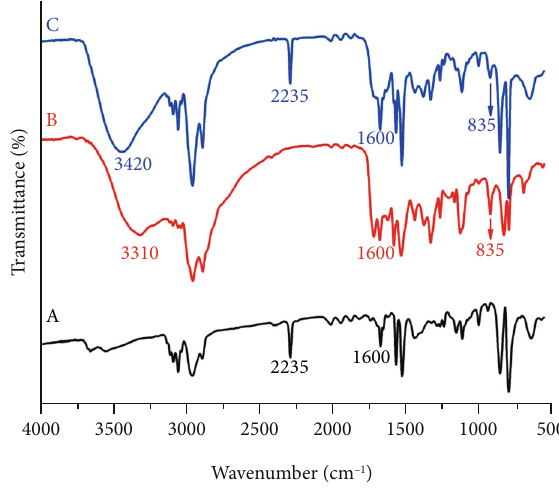
Figure 4: FT-IR spectra of (a) neat shell polymer (SAN), (b) neat curing agent (amine), and (c) their corresponding core-shell capsules.